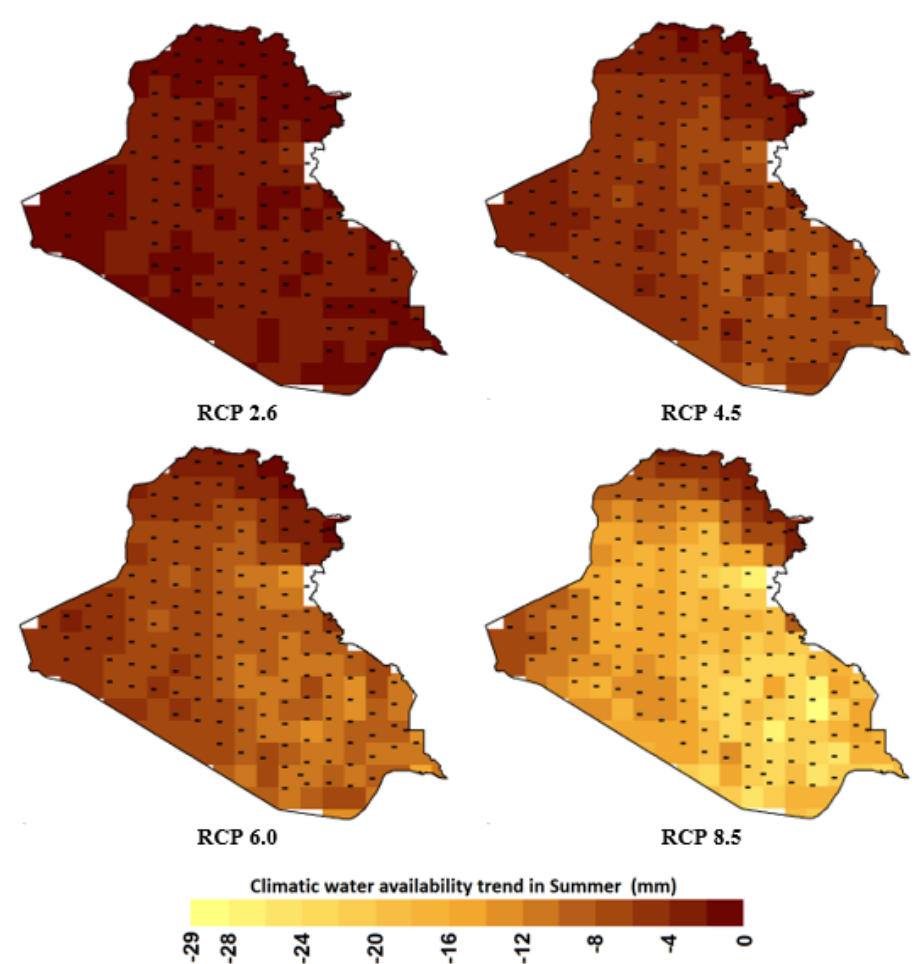
Figure 7. Spatial variations of summer CWA trends for different RCPs during 2010–2099, estimated using the mMK test at p = 0.05.